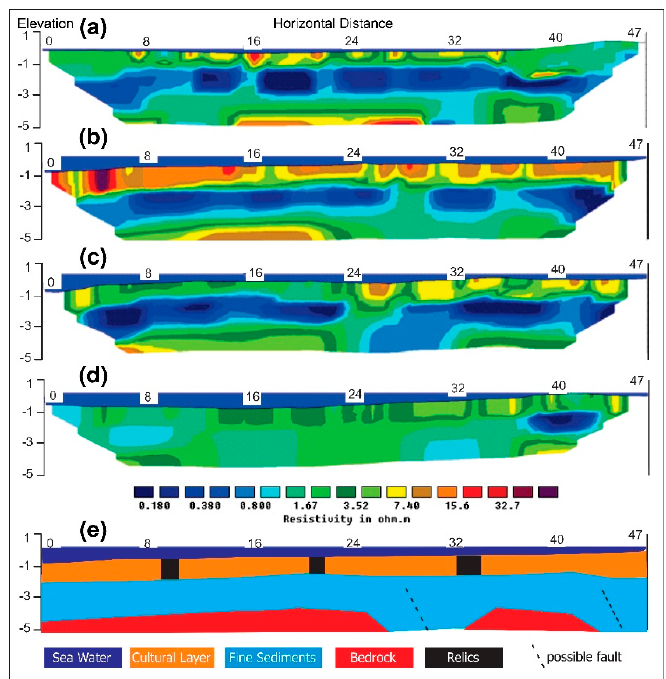
Figure 10. Representative 2-D resistivity inversion models from Grids 1 ( a ); 2 ( b ); 4 ( c ) and 5 ( d ) describing the vertical stratigraphy below the sea; ( e ) Simplified conceptual model of the main stratigraphic units interpreted though the 2D electrical resistivity tomography (ERT) models. The vertical and horizontal axis are given in meters.